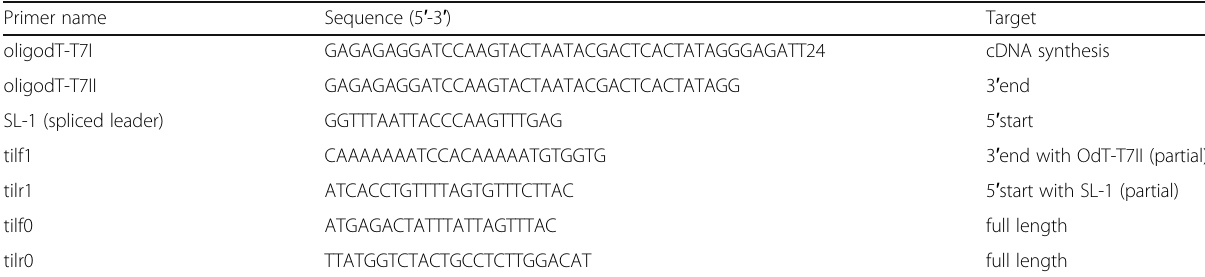
Table 1 Primers list used for Sra - til gene amplification. All primers were ordered from Eurofins MWG/Operon